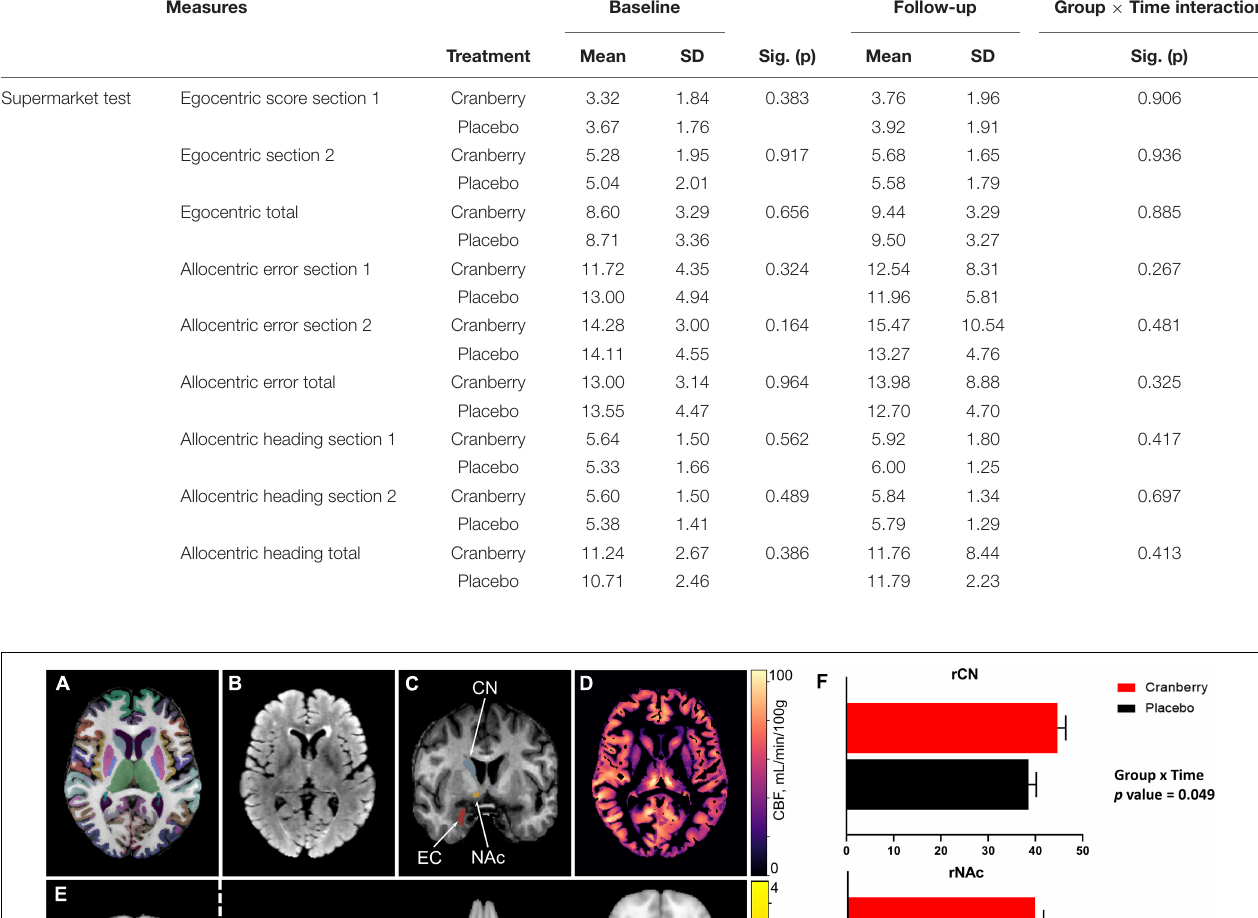
TABLE 3 | Spatial navigation performance at baseline and follow-up, differences between groups at baseline (Mann Whitney U independent-samples test), and group × time interactions on linear mixed modelling.